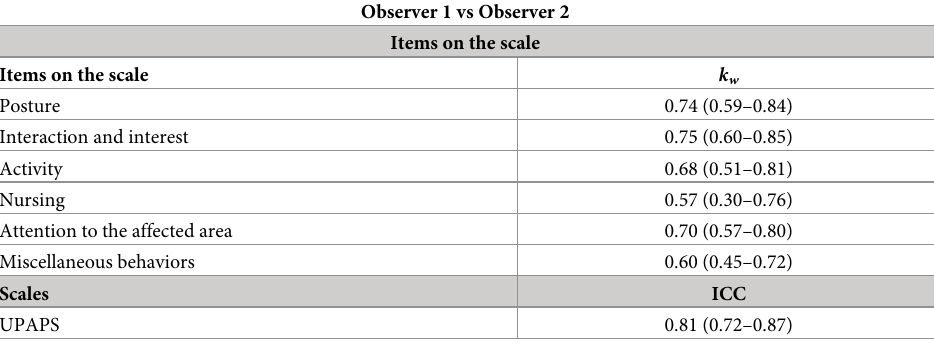
Table 3. Weighted kappa ( k w ) or intra-class correlation coefficient (ICC) and confidence interval of the 95% from inter-observer matrix agreement of each item and the sum of the UPAPS applied for all castrated piglets (n = 39) over all